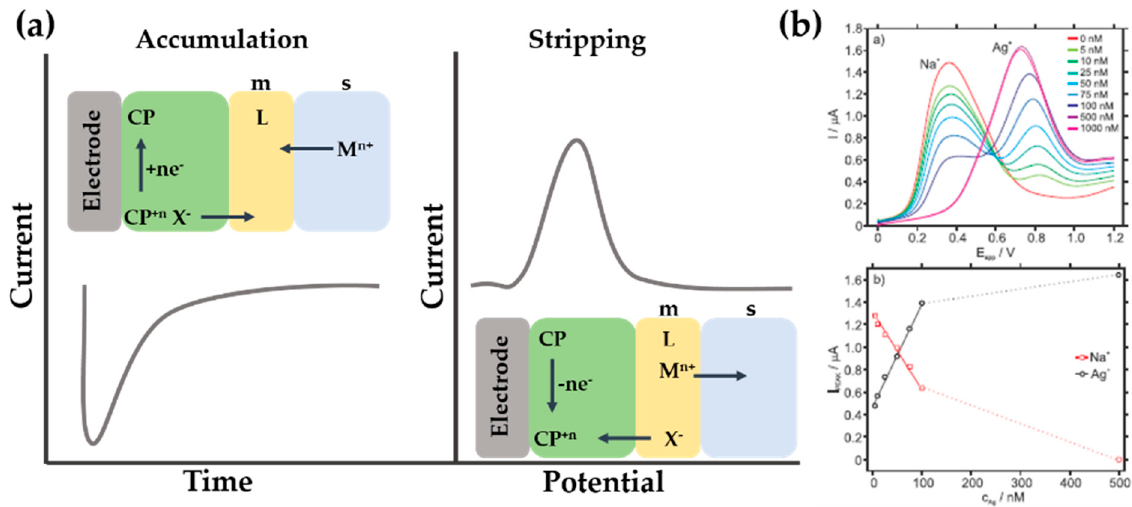
Figure 4. ( a ) Schematic illustration of the accumulation of ions in the ionic-selective membrane (m) and the corresponding stripping towards the solution (s) with a representation of the associated chemical reactions, and the potentiostatic accumulation response and the anodic stripping voltammogram. ( b ) Linear sweep voltammograms obtained during the stripping of Ag + at increasing concentrations (indicated on the figure) in 10 mM NaNO 3 background solution ( top ), and plot of the peak current for the peaks corresponding to the Na + and Ag + transfers versus the Ag + concentration ( bottom ). Adapted from reference [60].